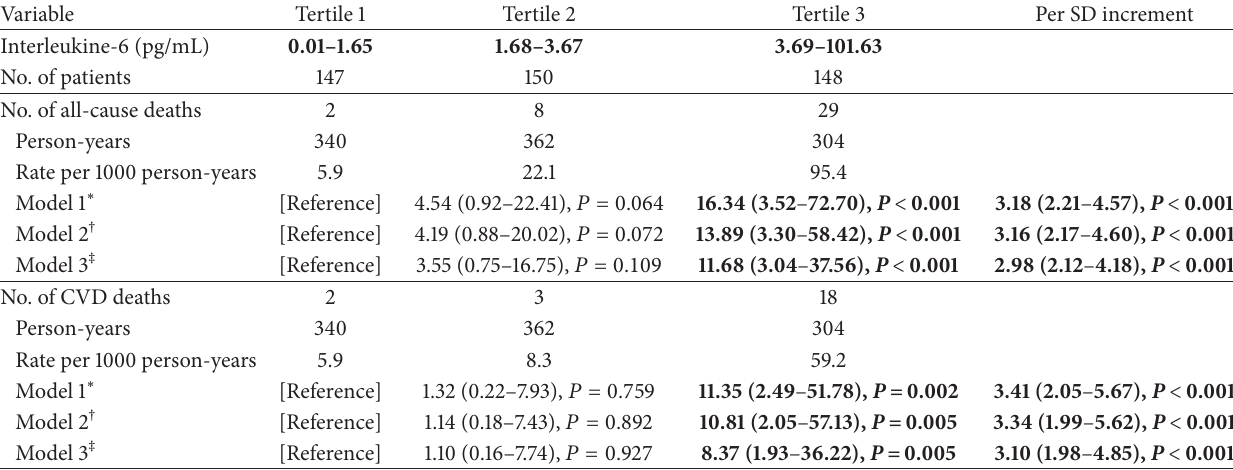
Table 3: Hazard Ratios for All-cause and Cardiovascular Mortality According to Interleukine-6 Quartiles and Continuous Levels in